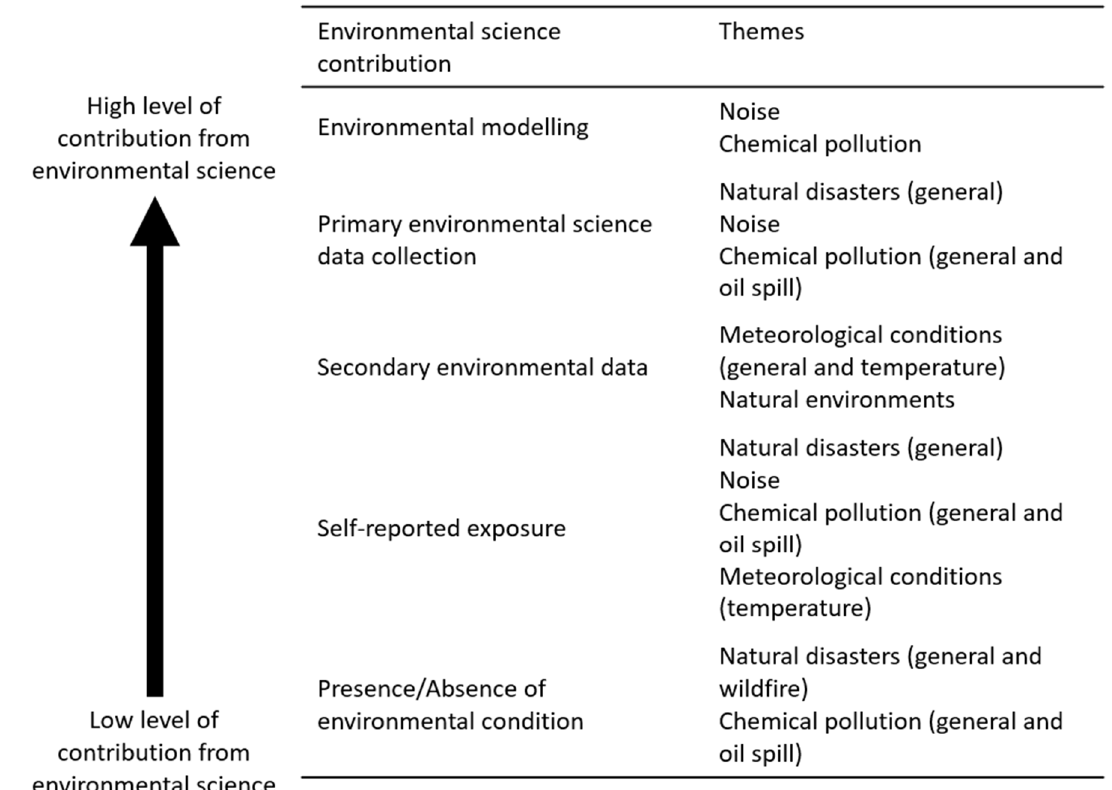
Figure 2. Varied levels of contributions of environmental science to mental health research. Arrow indicating the extent to which the environmental part of the study had contributions from environmental science.